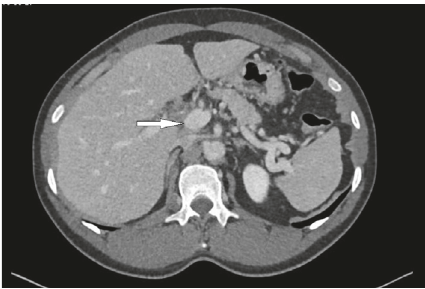
Figure 1: Contrast-enhanced CT scan showing pericholecystic fluid and partial filling defect in the superior mesenteric vein (white arrow).